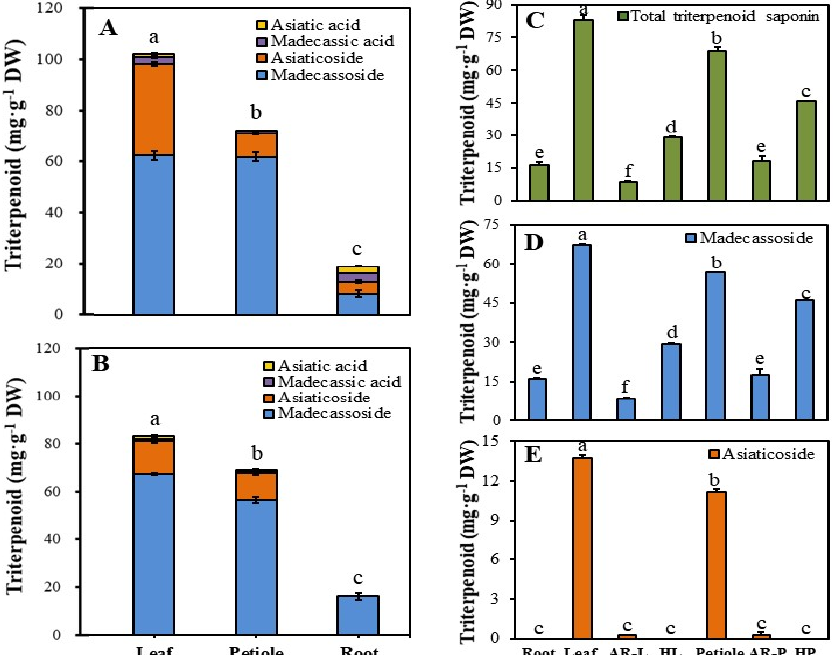
Figure 5. Comparison of the triterpenoid contents in HR lines, ARs, and source explants. ( A ) Ex vitro-grown plant; ( B ) In vitro-grown plant; ( C ) total triterpenoid contents, ( D ) madecassoside content; ( E ) asiaticoside content. AR-L and -P, leaf- and petiole-derived AR lines, respectively; HL and HP, leaf- and petiole-derived HR lines, respectively. Data represent mean ± SE. Different lowercase letters above bars indicate significant differences (DMRT; p ≤ 0.05).